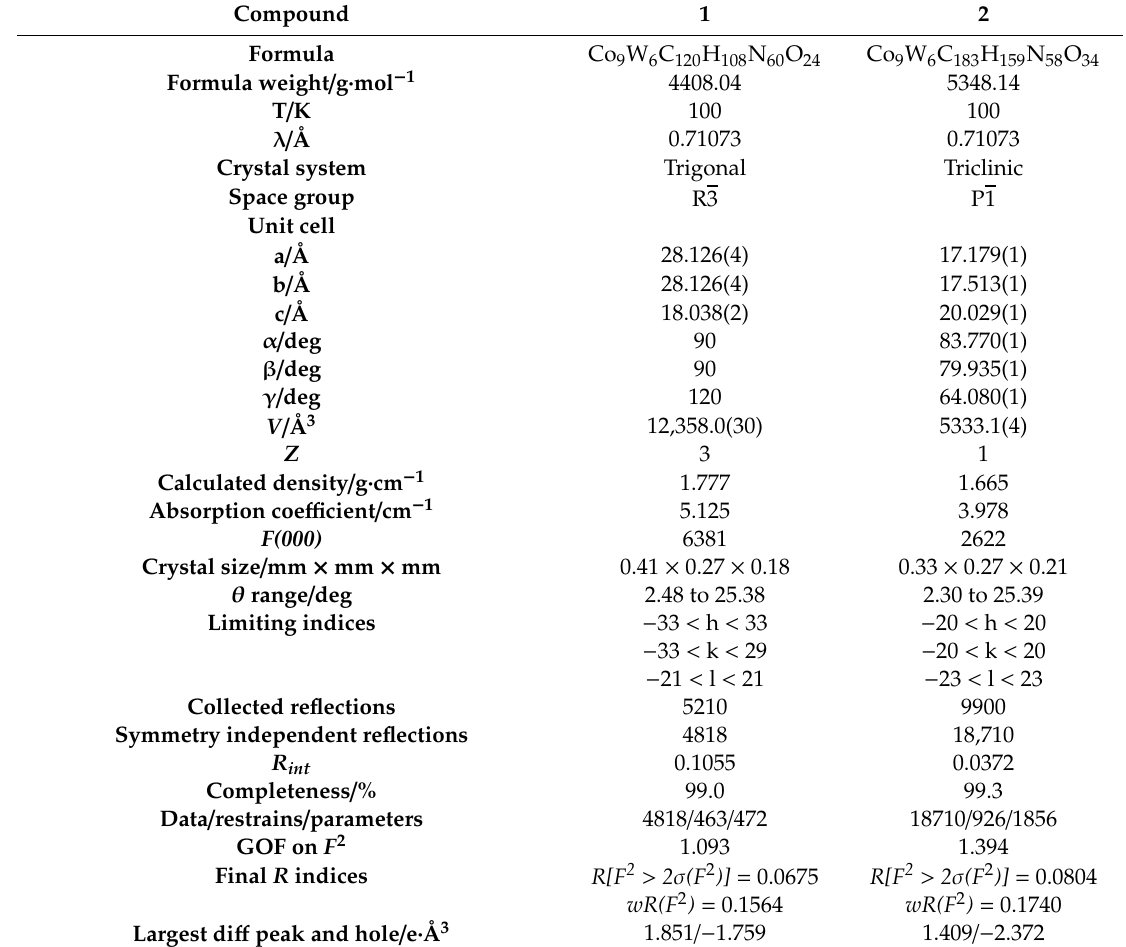
Table 1. Crystal data and structure refinement for 1 and 2